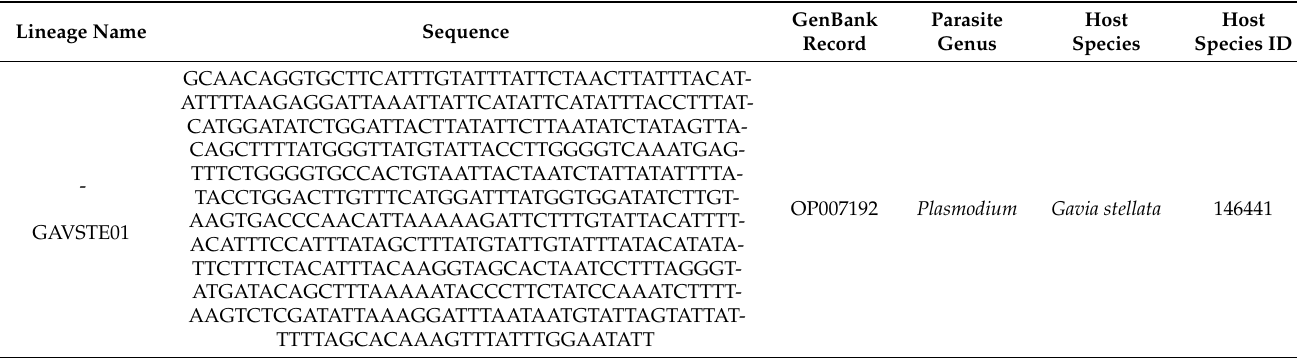
Table A1. Specific information on the new lineages submitted to